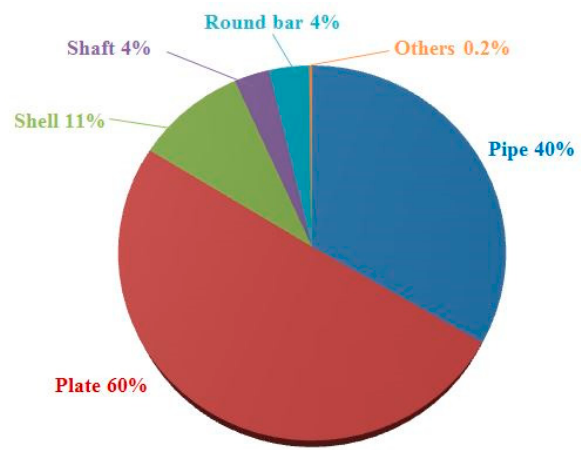
Figure 3. Research status of surface crack growth in different structures.